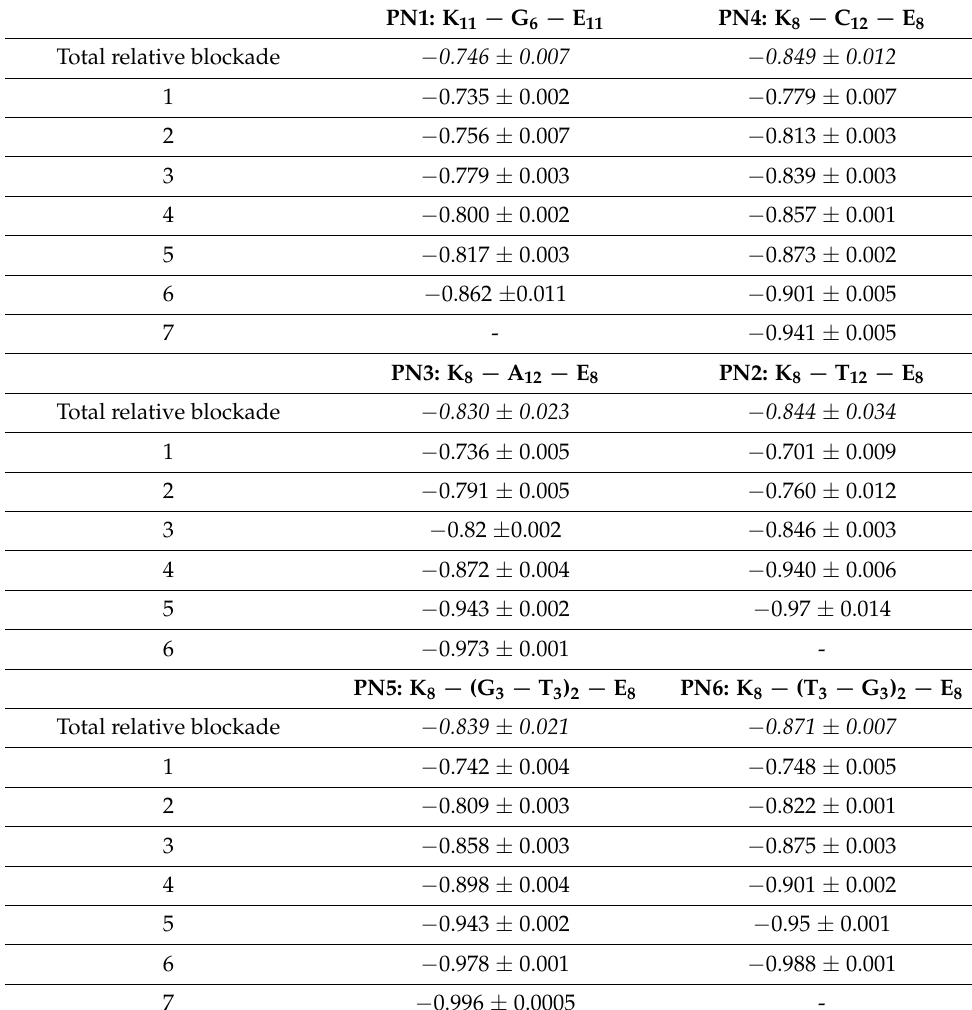
− I open Table 2. Relative blockage values I blocked calculated for the average “blocked” substate (total relative I open blockade), as well as additional substate blockades seen in the zoomed-in traces in Figures 2 and 3, denoted by corresponding numbers, at ∆ V = + 150